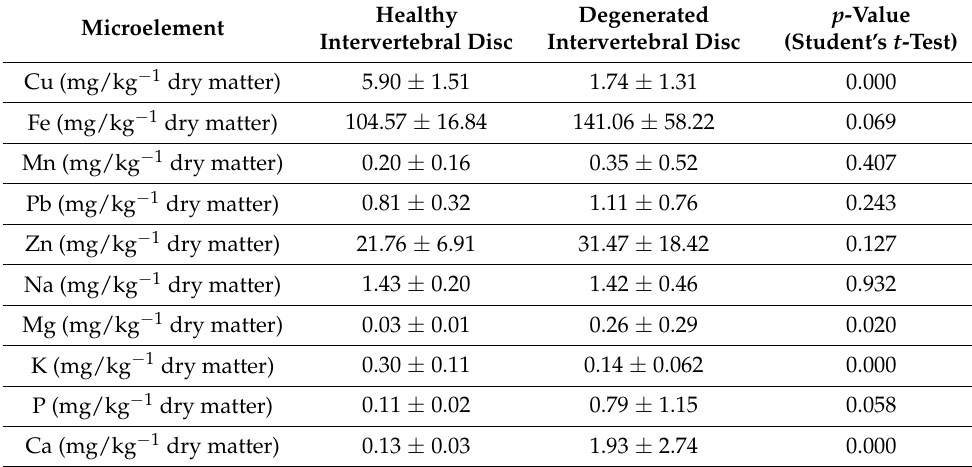
Table 3. Concentrations of selected elements in healthy and degenerated intervertebral discs.